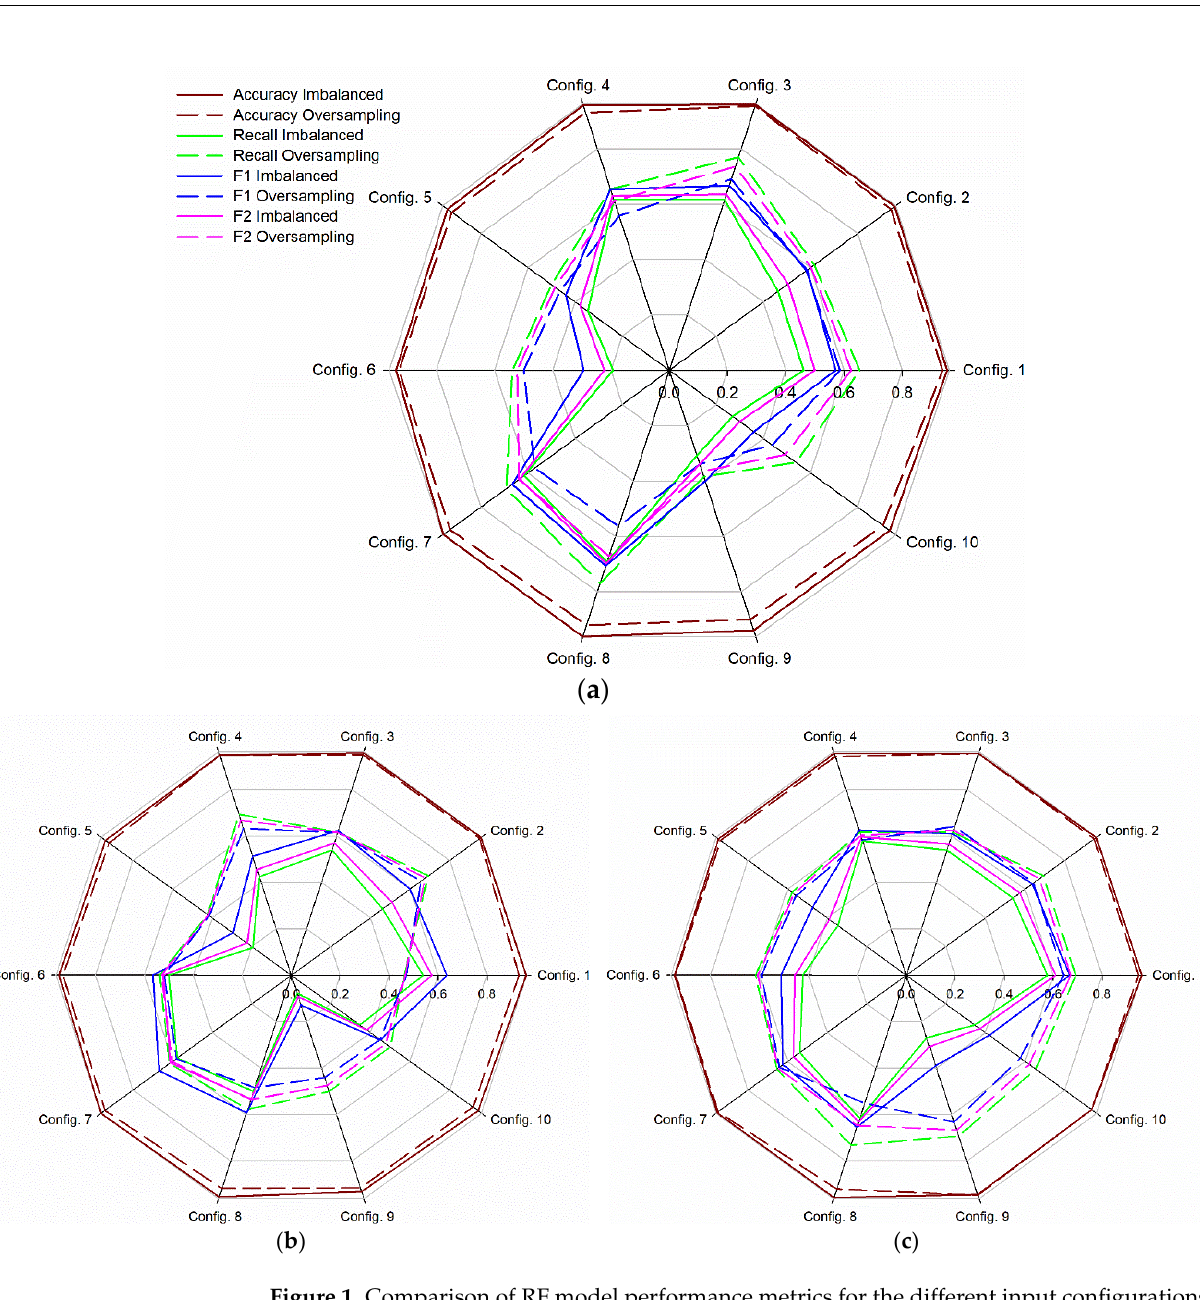
Figure 1. Comparison of RF model performance metrics for the different input configurations and the imbalanced and oversampling-based balanced datasets for T = 3 days ( a ), T = 6 days ( b ) and T = 10 days ( c ).